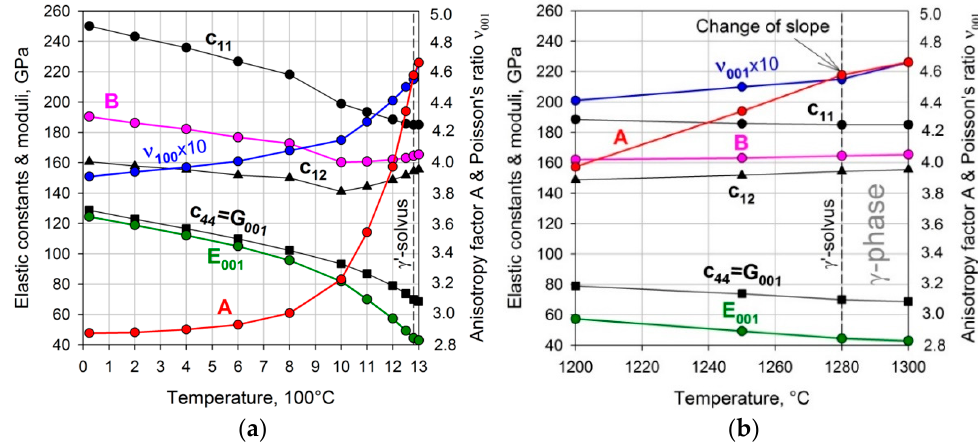
Figure 5. Temperature dependence of elastic stiffnesses { c 11 , c 12 , c 44 } , Young, shear, and bulk moduli, respectively E 001 , G 001 , and B , Poisson’s ratio ν 001 , and Zener factor of elastic anisotropy A . ( a ) Is the presentation for the wide range 24–1300 °C and ( b ) gives an enlarged presentation for the vicinity of γ ’-solvus temperature 1280 °C.